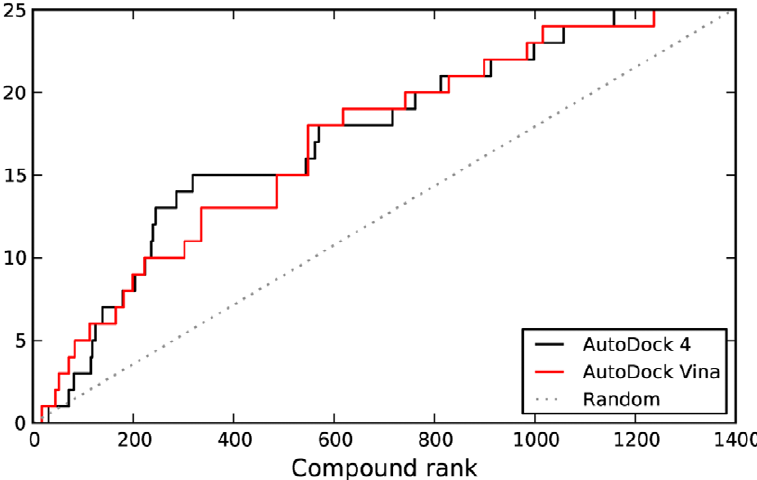
Figure 2. Virtual screen ranking of NCI Diversity Set II. The 1,364 members of DSII were docked to HIV protease using AD4 and Vina, then ranked by predicted binding energy. The plot shows the number of active compounds (determined via DSF) retrieved versus the total number selected. The dashed line indicates the number of actives that would be expected to be returned based on a random selection of compounds.